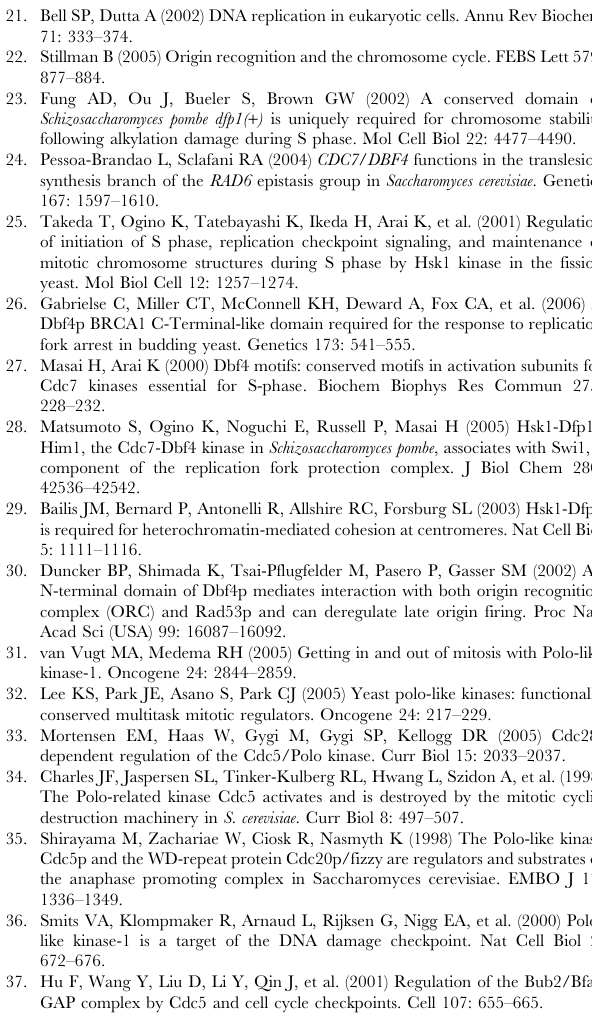
mating pheromone and released into the cell cycle at 30 u C. Alpha- factor was added back after budding to follow a single cell cycle. Samples were taken at the indicated time points and scored for release of Cdc14 from the nucleolus. Figure S5 Some Dbf4p persists after Cdc20 activation during an unperturbed cell cycle. PDS1-HA3 DBF4-Myc18 (M3161) was arrested in G1 with mating pheromone and released into the cell cycle at 20 u C. Samples were taken at the indicated time points. Protein extracts were made for Western blotting and cells processed for DNA content analysis by flow cytometry. Western blots were probed with 9E10 a -Myc (Dbf4-Myc18) and 12CA5 a - HA (Pds1-HA) antibodies. Table S1 Yeast strains used in this study.